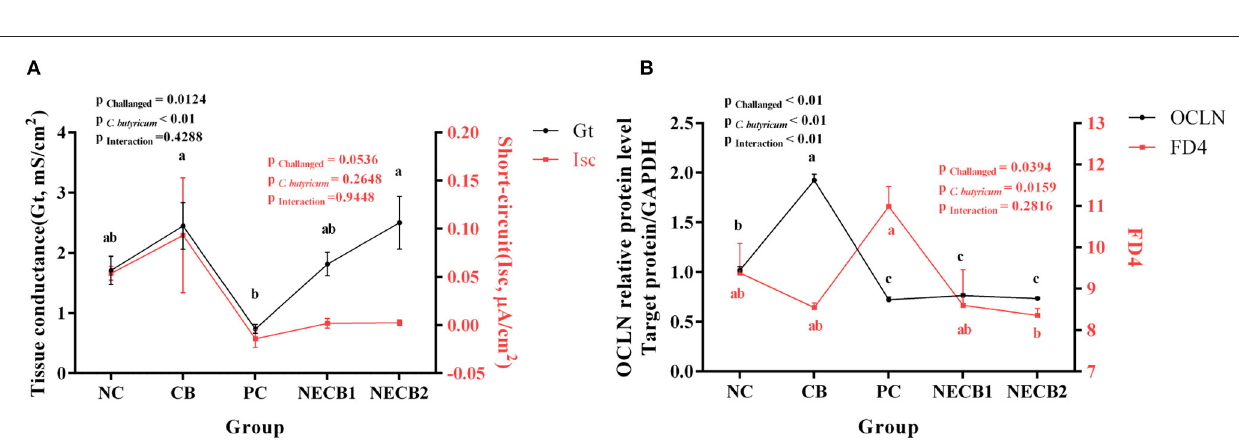
the barrier function of TJs. CLDNs also play an essential role in regulating cellular signal transduction and paracellular transport in the intestinal epithelium (Krause et al., 2008). ZO proteins are located on the surface of the inner cytoplasmic